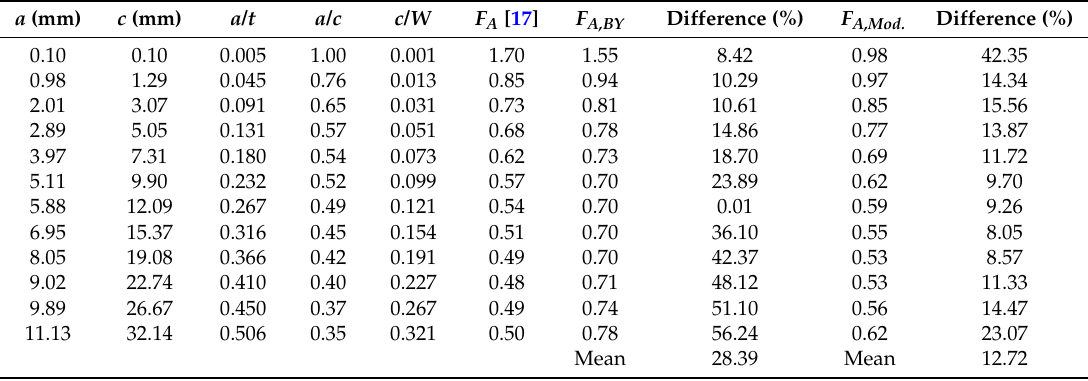
Table 5. Comparison of the dimensionless stress intensity factor values from the Baik-Yamada formula, the modified formula and the literature results by the three-dimensional finite element method at point A